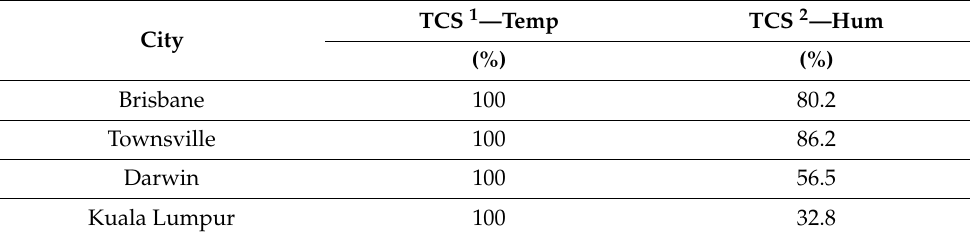
Table 3. Summary of thermal comfort indicators of the system operating in various cities. TCS 1 —Temp TCS 2 —Hum City (%) (%) Brisbane 100